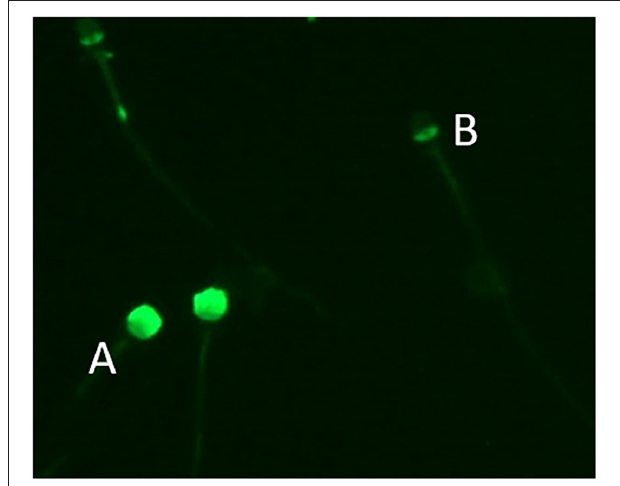
FIGURE 1 | Sperm acrosome stained with fluorescein isothiocyanate-conjugated peanut agglutinin (FITC-PNA). Sperm with (A) intact acrosome and (B) non-intact